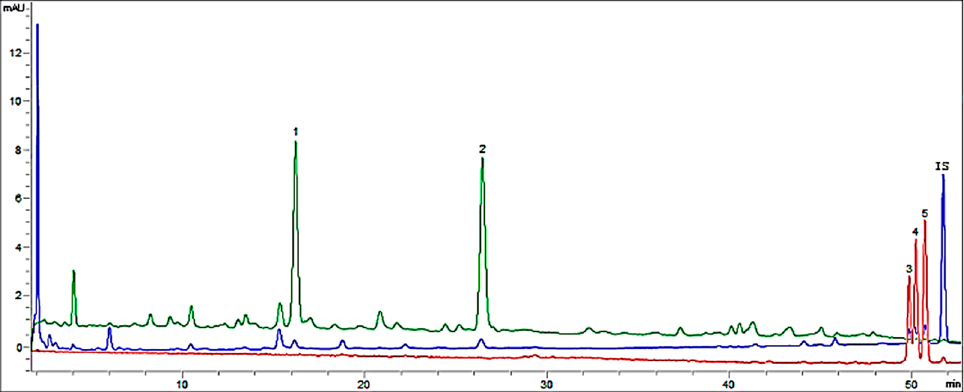
Figure 2. Chromatogram of a sample with added internal standard. Blue signal DAD = 280 nm, red signal DAD = 360 nm, green signal FLD Ex = 230 nm and Em = 280 nm. Peaks identified and quantified by HPLC 1: (+)-catechin; 2: ( − )-epicatechin; 3: isorhamnetin-3- O -glucoside; 4: kaempferol- 3- O -rutinoside; 5: isorhamnetin-3- O -rutinoside; IS: daidzein. Table 6. Phenolic compounds in the samples identified and quantified by HPLC-DAD-FLD. Sum Kaempferol- Isorhamentin-3- O - Genotype Isorhamentin- Flavan-3-ols 3- O -glucoside 3- O -rutinoside rutinoside